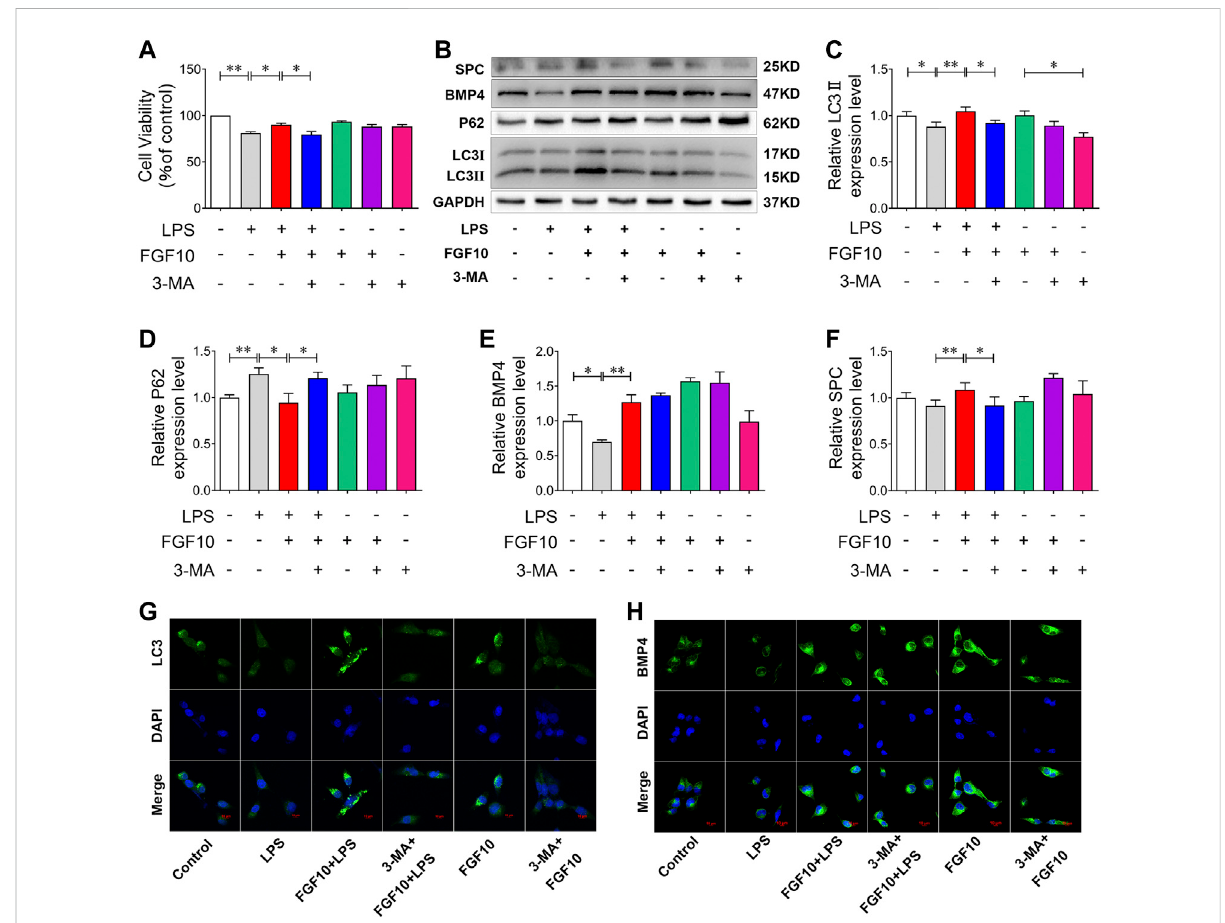
FIGURE 7 Inhibition of autophagy exacerbates cytotoxicity induced by LPS in AECs. (A) After exposure to 2.5 mM of 3-MA for 2 h and 10 ng/ml of FGF10 for 1 h,theviabilityof AECswith the administration of 10 μ g/mlof LPSwas detected byCCK-8. (B) The protein expression of LC3, P62, BMP4, andSPCwasexaminedbyWesternblotting. (C – F) QuantitativeanalysesofLC3,P62,BMP4,andSPCprotein. (G,H) TheexpressionofLC3(green)and BMP4 (green) of AECs was analyzed by immunostaining (magni fi cation ×400). The data are presented as the mean ± SEM, n = 3. * p < 0.05, * * p <